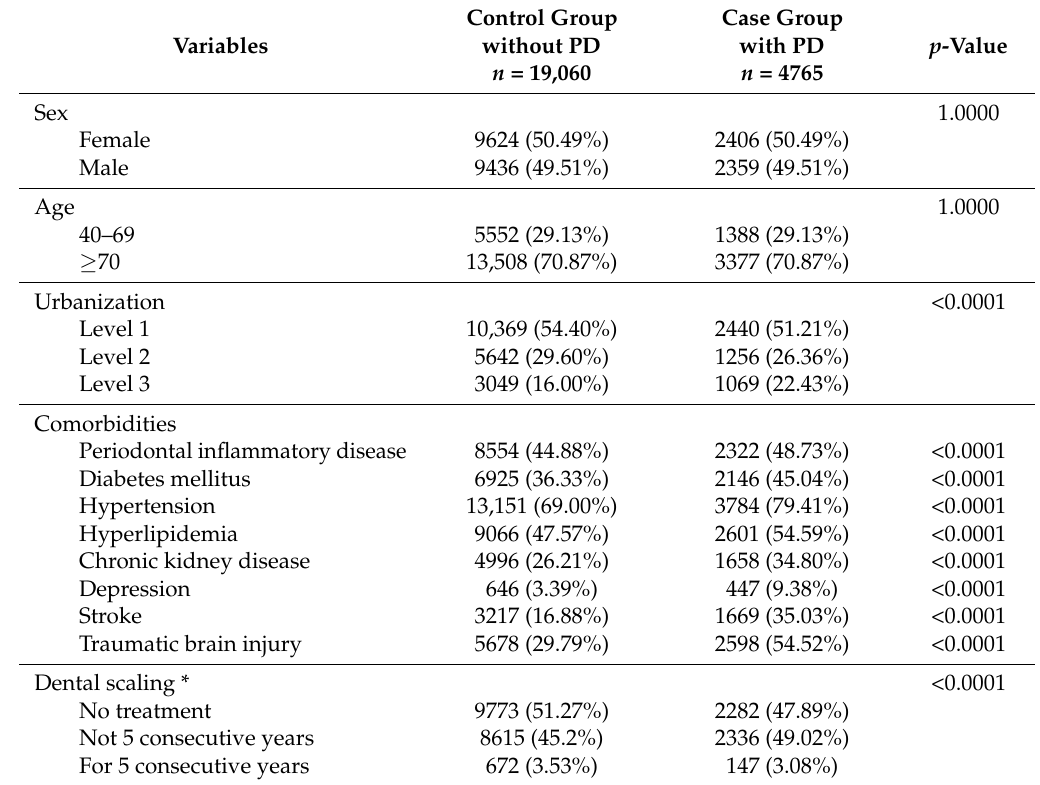
Table 1. Characteristics among the Parkinson’s cases and age- and sex-matched controls at index